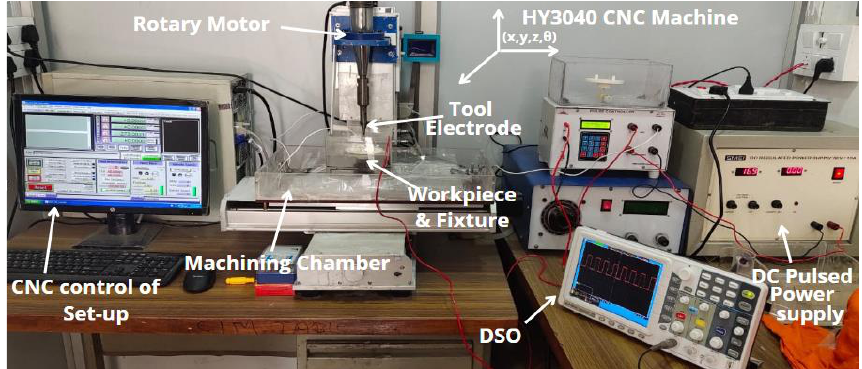
Figure 1. Pictorial view of ECDM setup.